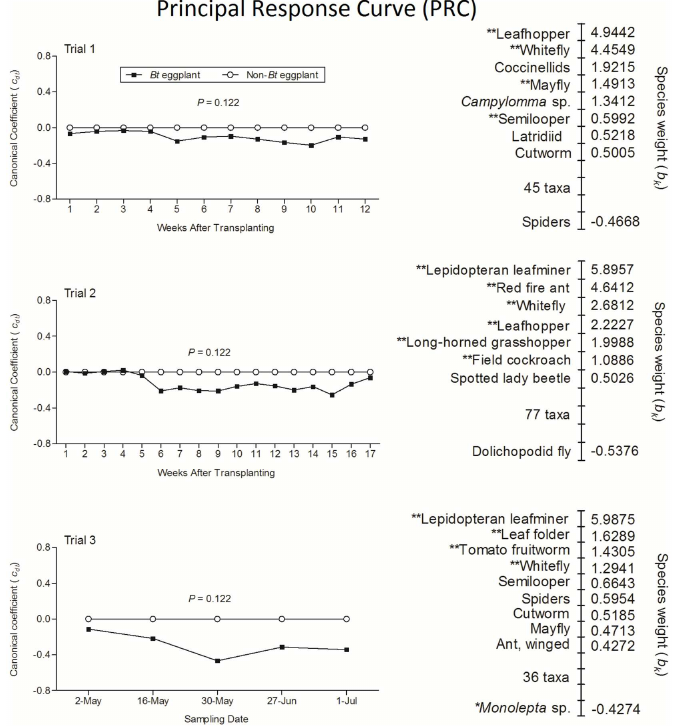
Fig 2. Principal response curve patterns and species weight of non-target arthropod (NTA) communities in Bt and non-Bt eggplants. Vertical axis represents the differencein community structure between Bt and non-Bt eggplantsexpressedas regressioncoefficient ( Cdt ) of the PRC model. The P value indicatessignificance of the PRC over time based on restricted Monte Carlo permutation test. The species weight ( b k ) can be regardedas affinity of the taxon to the principal response.Only species with weights less than -0.05 or greater than 0.5 are